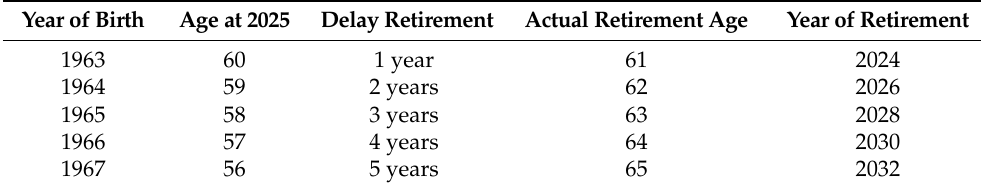
Table 10. Delayed retirement plan II (male